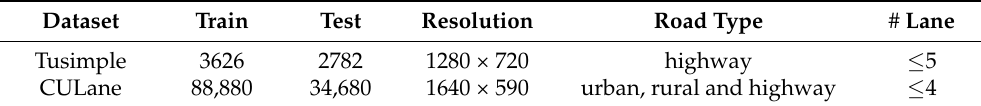
Table 1. Basic information of the